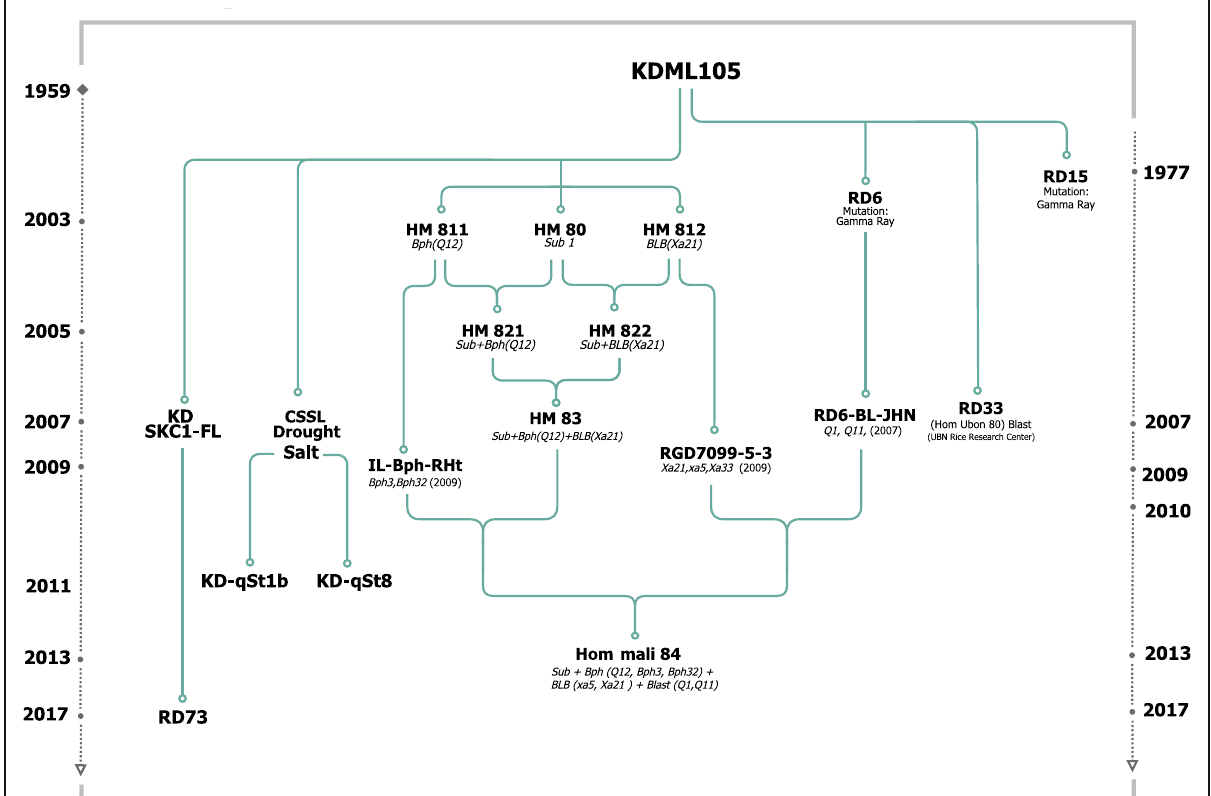
Fig. 2 Schematic development of KDML105 from a well-adapted, local aromatic rice cultivar to new KDML-like rice varieties with resistance to submergence, bacterial leaf blight, leaf/neck blast, and brown planthopper using comprehensive marker-assisted gene/QTL pyramiding backcross